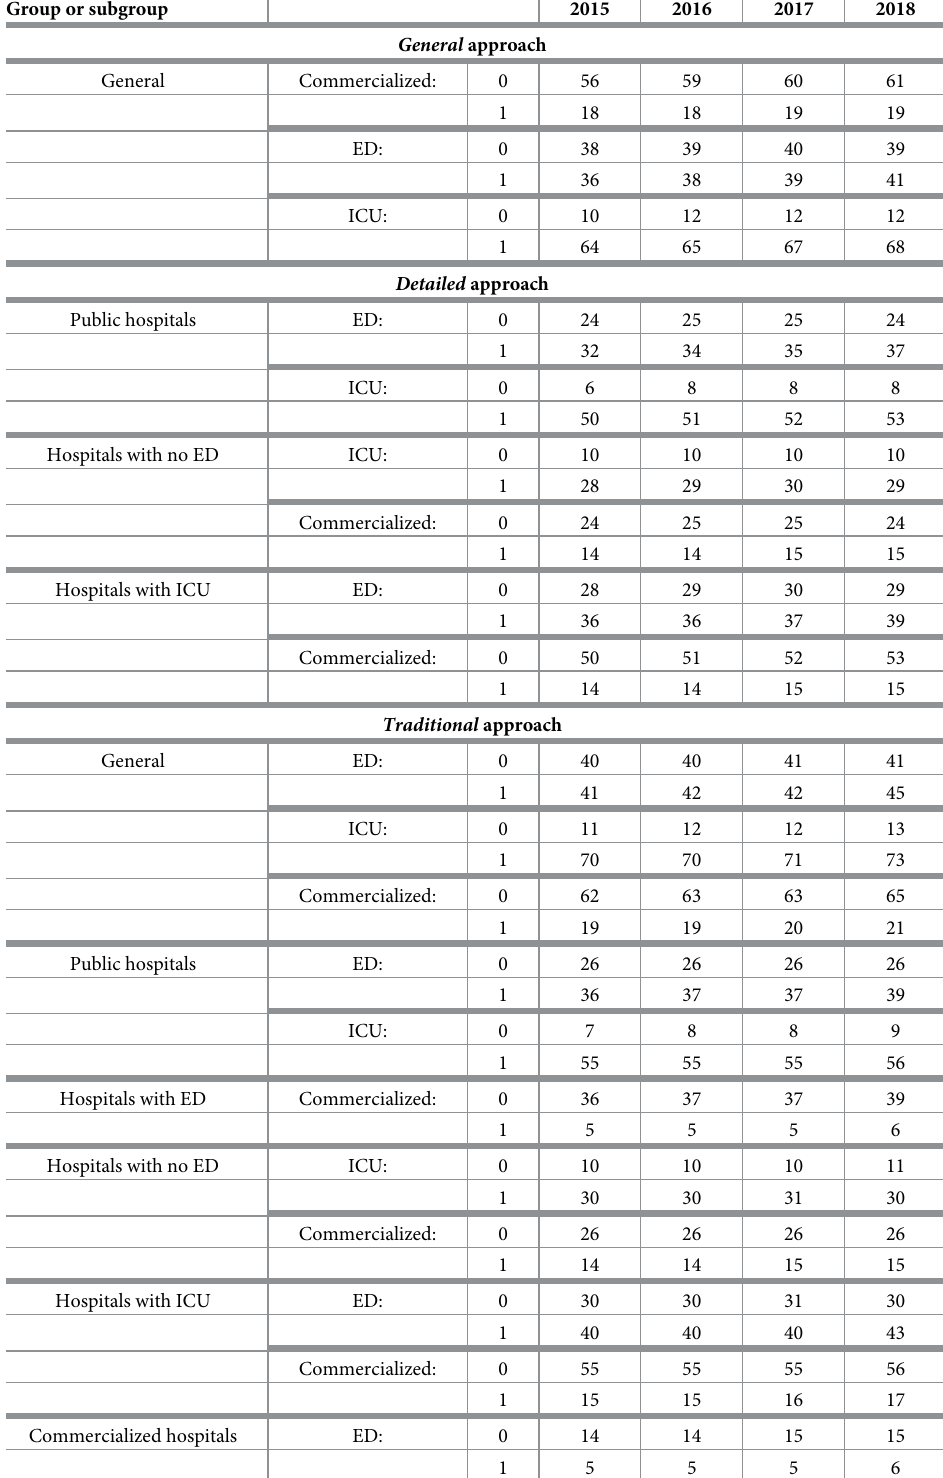
Table 3. Numbers of hospitals by year, subgroup and approach. Group or